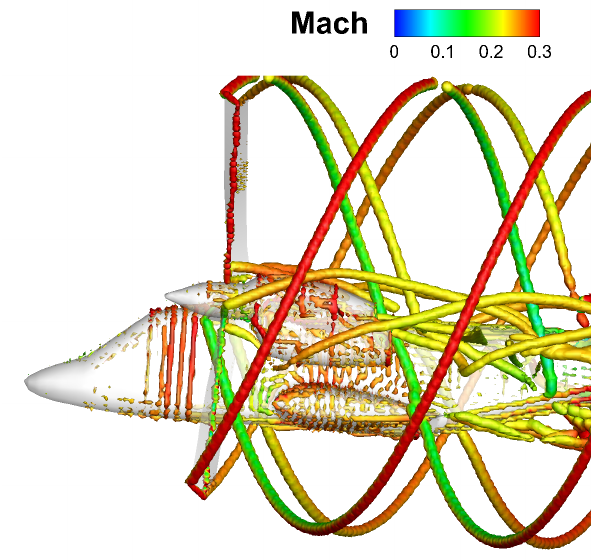
Figure 24. Instantaneous flow field computed by DUST in cruise flight condition at ψ = 270 ◦ , θ N = 0 ◦ , V ∞ = 160 kts, Ω = 517 RPM; iso-surface of